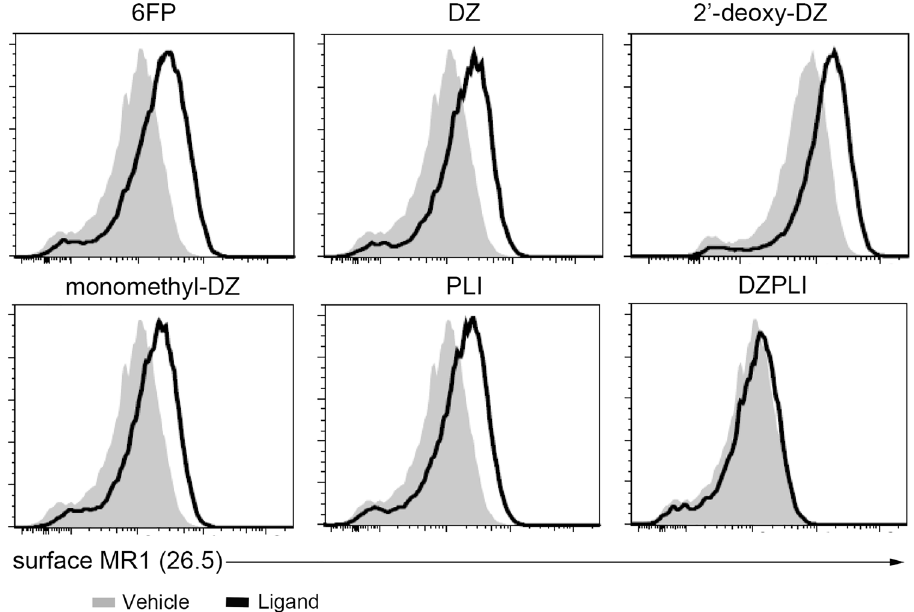
Figure 6. MR1T cell activating potential of MR1 ligands and MR1 stabilization on the cell surface. WT BEAS-2B cells overexpressing MR1-GFP were incubated with indicated ligands at 100 µM for 16 h. MR1 on the cell surface was detected by surface staining with the α-MR1 26.5 antibody conjugated to APC. Grey shaded histograms represent the vehicle and black solid histograms represent the ligand. Histograms are representative of 2 independent